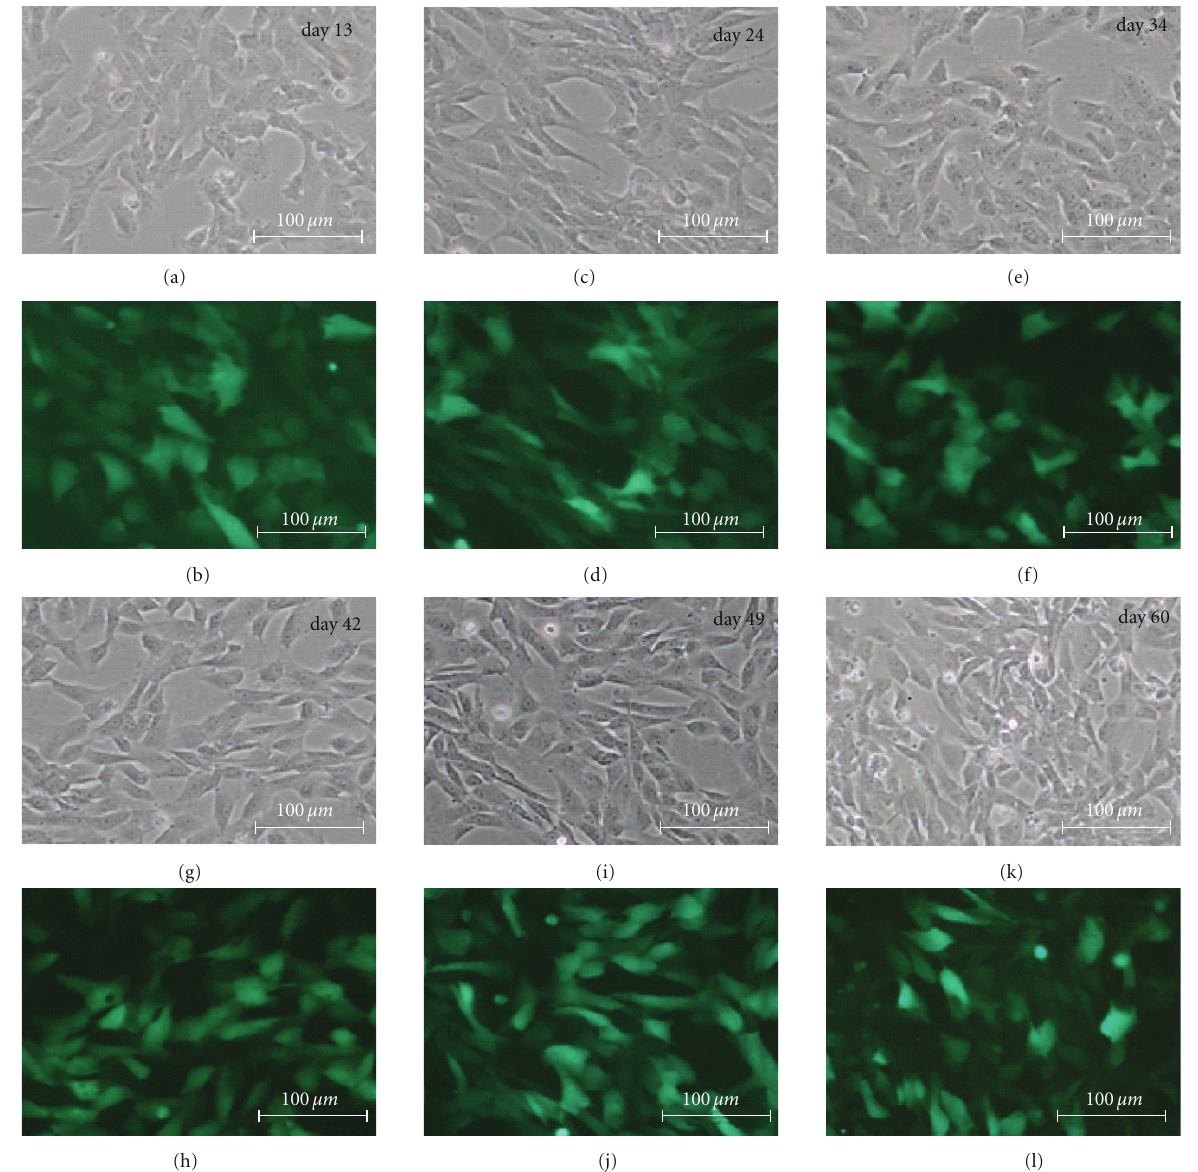
Figure 1: GDNF-transduced cNPCs: morphology and reporter gene expression. Feline NPCs transduced using a bicistronic lenti-GDNF- GFP vector and cultured under proliferation conditions (UM) for 60 days (p9 − p26). Cellular growth, morphology, and GFP expression were monitored over this time period. In this figure, paired phase contrast ((a), (c), (e), (g), (i), (k)) and fluorescence ((b), (d), (f), (h), (j), (l)) micrographs of the same field are presented for each of 6 sequential time points, as indicated. Transduced cNPCs exhibited consistent